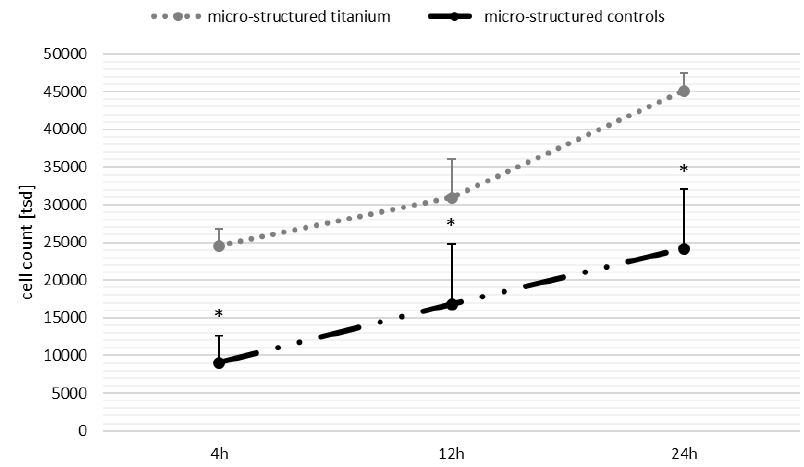
Figure 6. Comparison of cell count after 4, 12 and 24 h between microstructured titanium samples and controls. The circles correspond to the mean value, and the line on top corresponds to the ± standard deviation. Statistically significant differences ( p < 0.05) are marked with an asterisk.